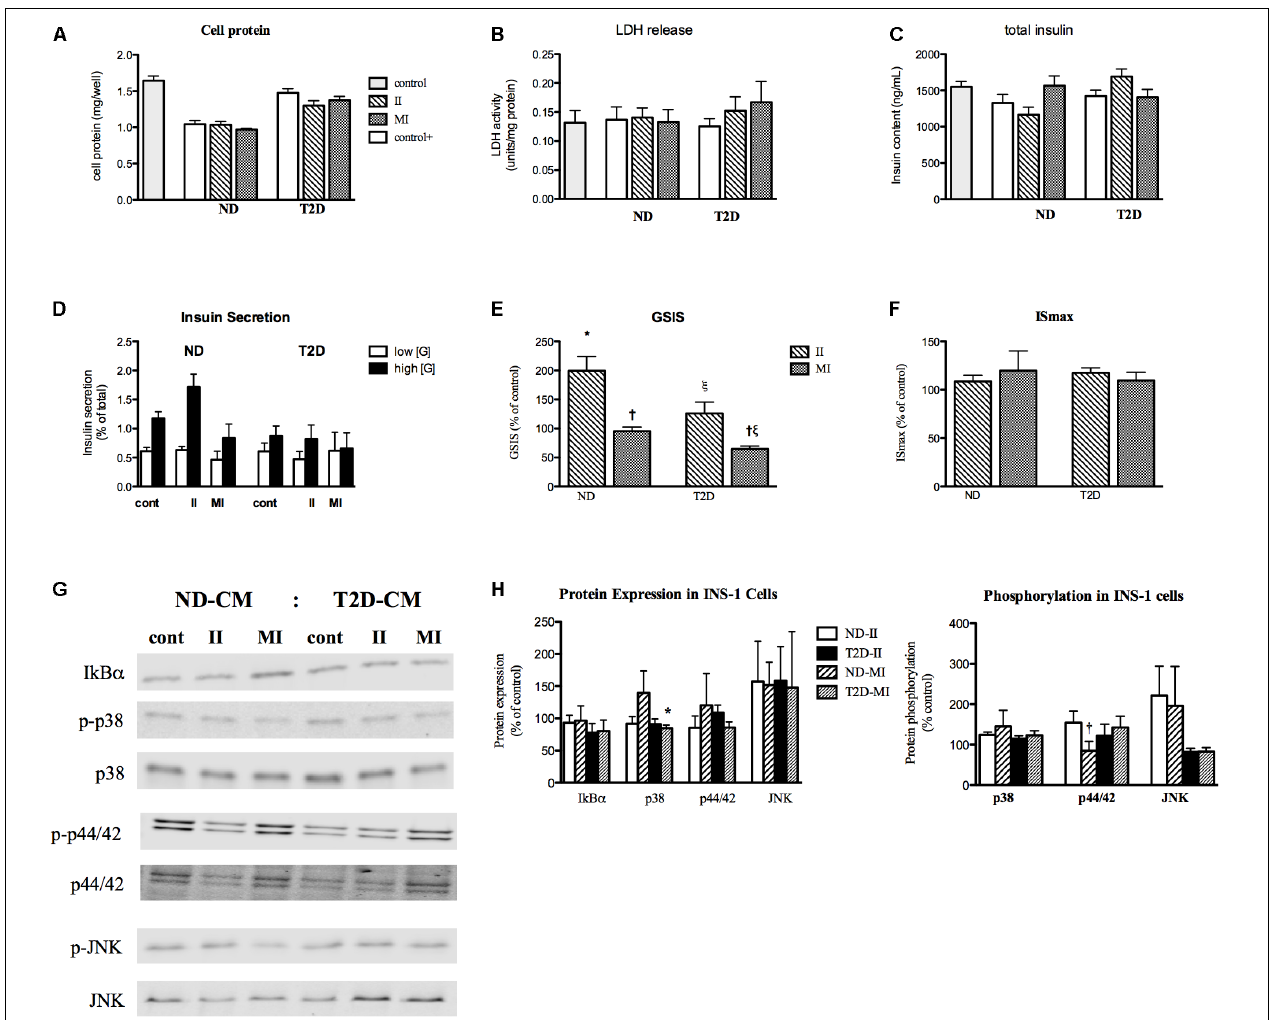
FIGURE 7 | Effects of CM from ND- and T2D-MT challenged with II and MI conditions on INS-1 cell function. INS-1 cells treated with the indicated CM for 24 h before harvest or assay. (A) Total cell protein ( n = 12–24). (B) LDH release ( n = 12–24). (C) Total insulin content ( n = 12–24). (D) Insulin secretion ( n = 10–14). (E) GSIS ( n = 10–14). (F) IS max ( n = 8–14). (G) Representative western blots for IkB α , total and phosphorylated p38, p44/42, and JNK. (H) Quantization of western blots ( n = 4–8). Results presented as absolute value or as a percentage of the appropriate control, II or MI non-conditioned media. Ave + SEM. Panels (A–C) ; Control = RPMI: a-MEM (3:1) w/o treatment conditioned by MT from the same individual, control+ = RPMI: a-MEM (3:1) + II or MI not conditioned by MT. Panels (D,E,G) , control = RPMI: a-MEM (3:1) w/o treatment conditioned by MT from the same individual. * p < 0.05 vs. control, † p < 0.05 vs. II.